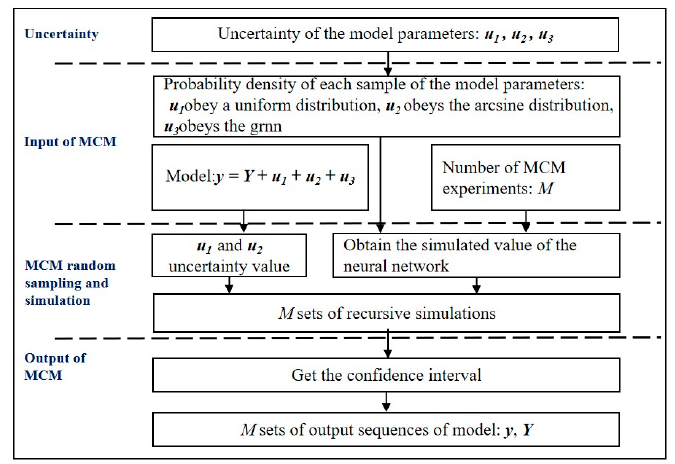
Figure 7. Uncertainty evaluation process based on MCM.